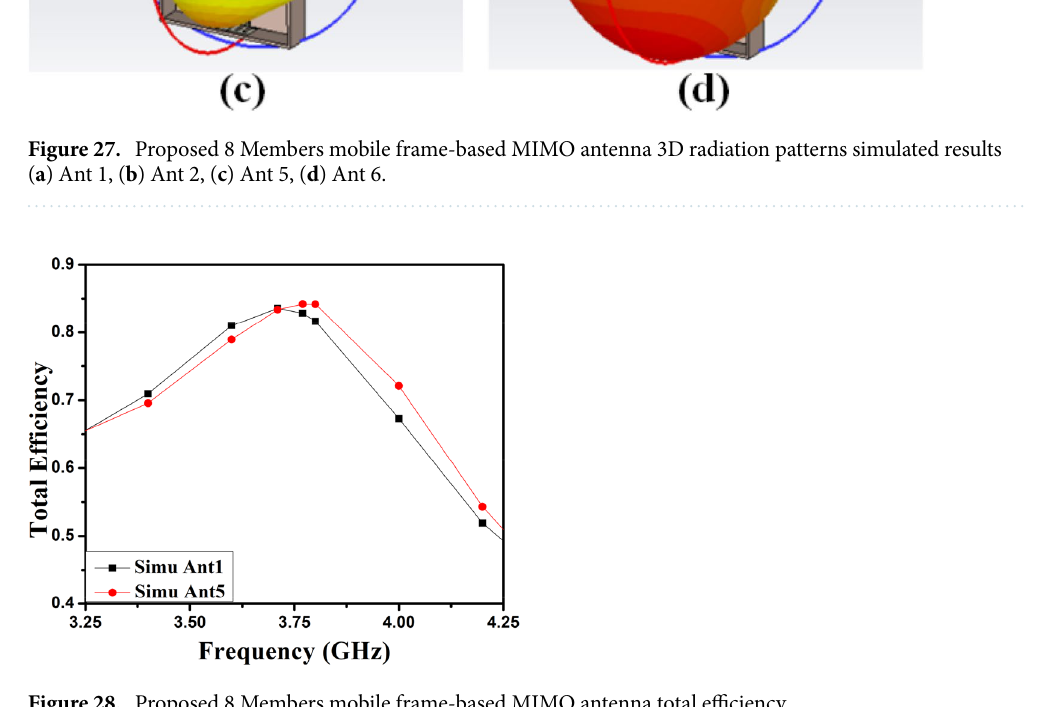
Figure 28. Proposed 8 Members mobile frame-based MIMO antenna total